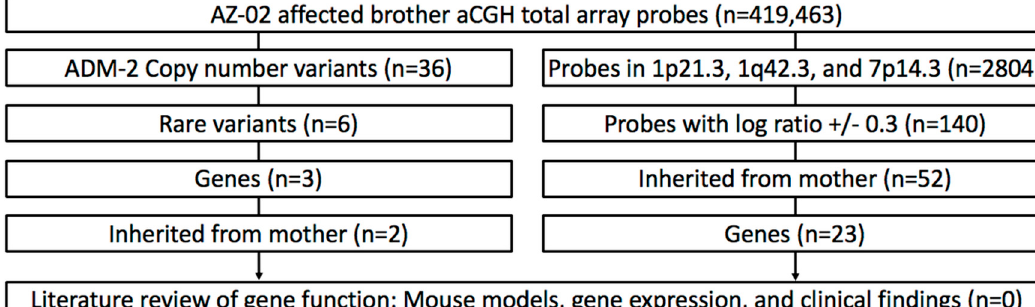
Figure 2. Workflow for genomic copy number variation (CNV) analysis of array comparative genomic hybridization (aCGH) data in the evaluated family. The major steps are shown in the left panel: (1) Low quality and noise probes removed, keeping real CNVs as described in the ADM-2 protocol in Materials and Methods ( n = 36). (2) The confirmed variants were evaluated for rarity by a review of the database of genomic variants (DGV) for the reported CNV findings in healthy individuals ( n = 6). CNVs that were reported more than five times in the DGV (fully overlapped and were the same type, amplification or deletion) were considered “polymorphic” variants and were excluded. (3) CNVs inherited from the mother were given higher priority ( n = 2). (4) Rare CNVs with known genes were considered in a biological role ( n = 1). (5) A gene review for gene function and testis-specific tissue expression was performed using the PubMed, OMIM, MGI, BioGPS, Unigene, and Aceview databases ( n = 0). In the right panel, the major steps of the analysis of probes in the translocation regions are shown: (1) The probes were reviewed using the ADM-2 protocol for one probe ( n = 2804). (2) All single probes with a log ratio of > 0.3 and < − 0.3 were analyzed ( n = 140). (3) CNVs that were also found in the mother were prioritized ( n = 52). (4) CNVs for the genes analyzed ( n = 23) and (5) rare genes were reviewed by a detailed literature and database search, as described above.